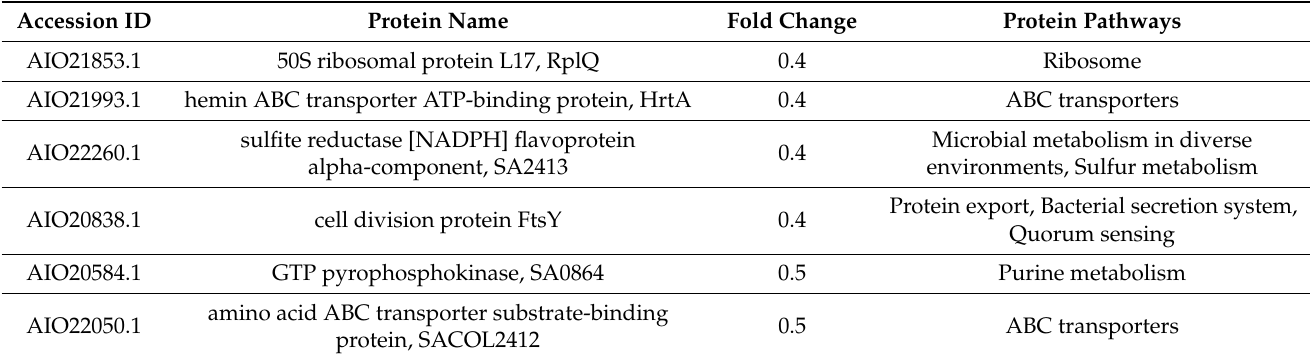
Table 3. Functional classification of the significantly downregulated proteins in hydrated biofilm in comparison to DSB ( p <